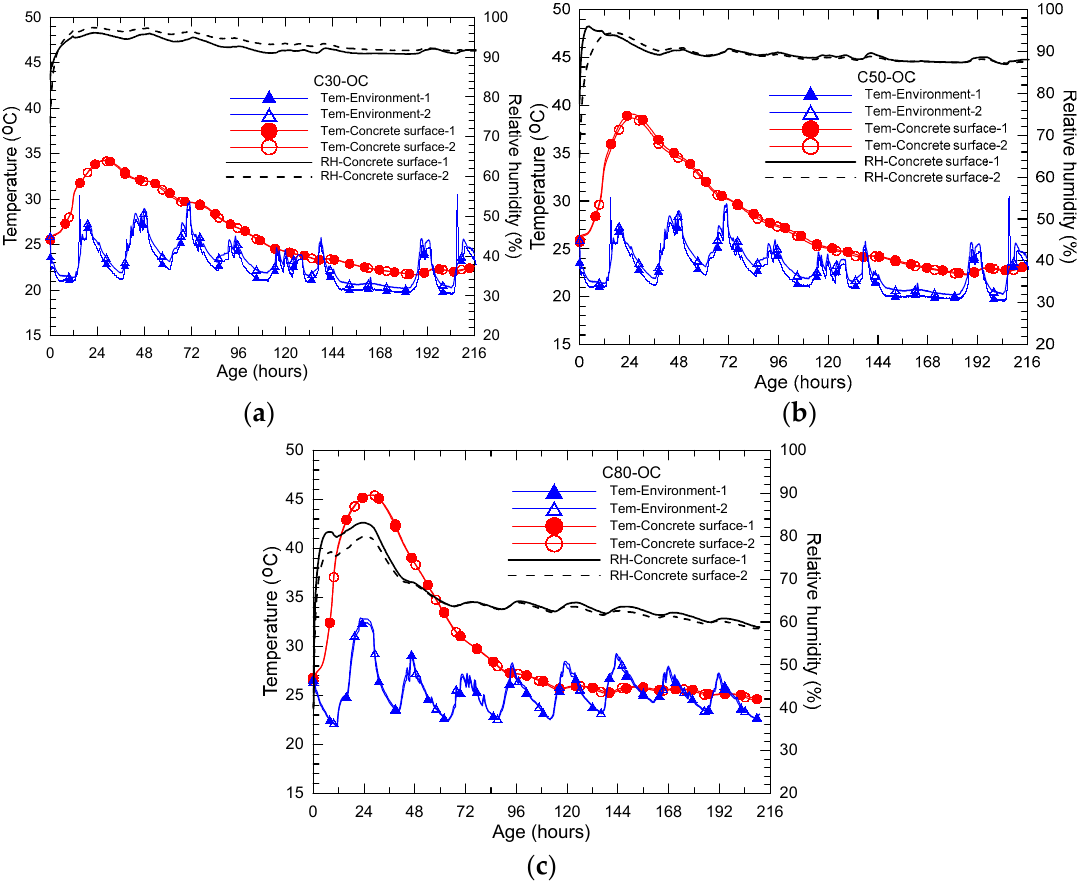
Figure 2. Development of temperature and relative humidity inside the curing box of concrete under insulation conditions ( a ) C30, ( b ) C50 and ( c ) C80.